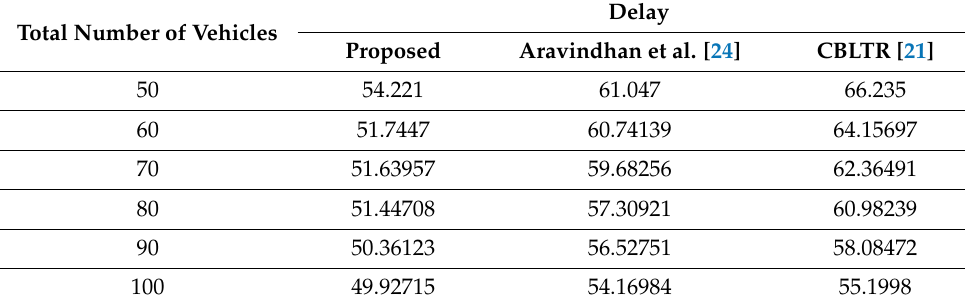
Table 8. Delay versus vehicular nodes in area (1500 ×